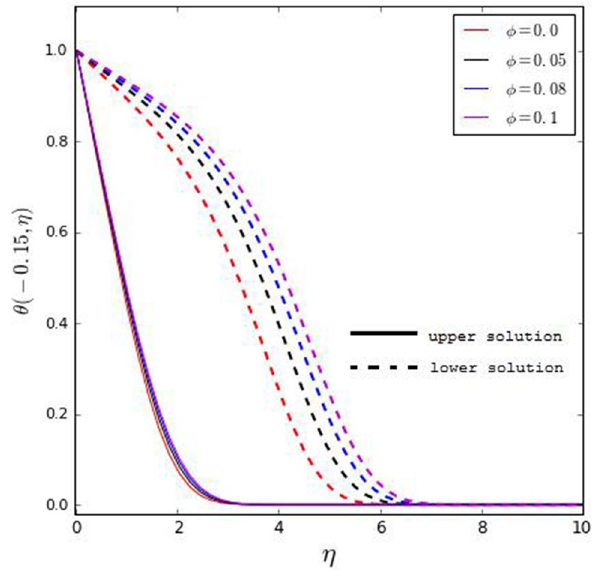
Fig. 9 Profiles for 𝜃 (− 0.1, 𝜂 ) for different 𝜙 = 0.05 for buoyancy opposing flow ( 𝜆 < 0 ) for fixed Pr = 6.7